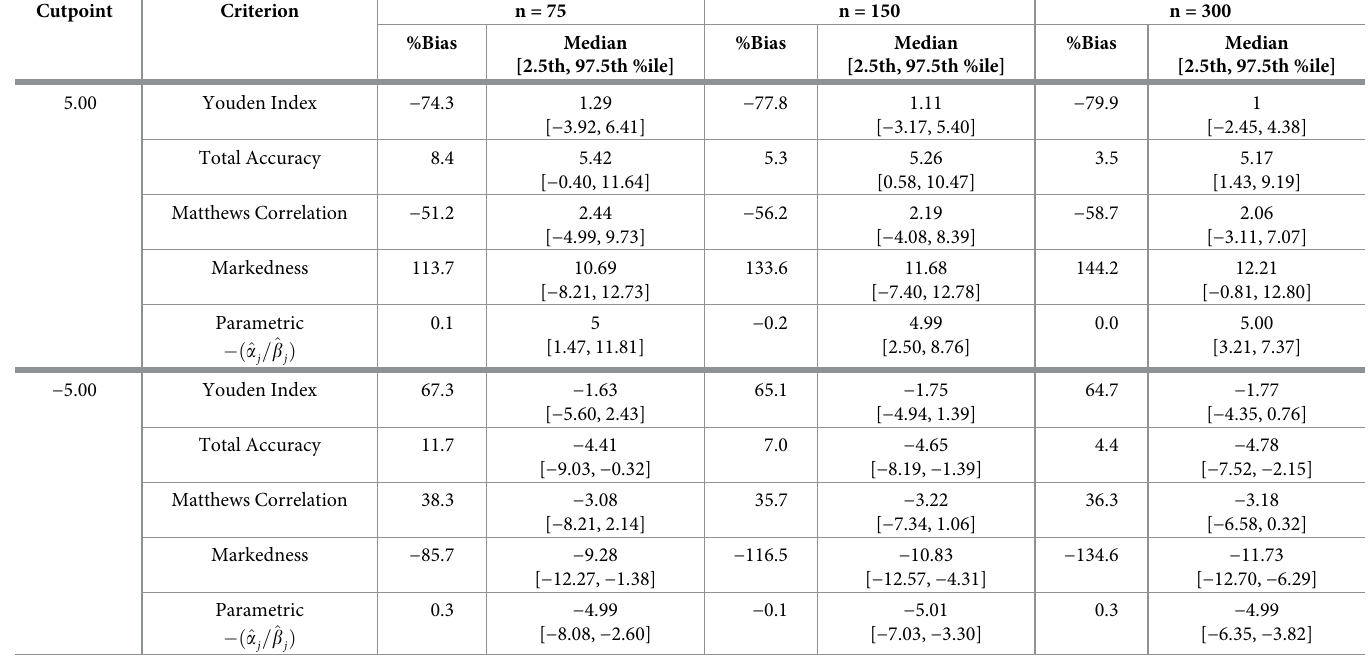
Table 6. Non-proportional odds simulation: NPO1. Percentiles and biases of cutpoints selected from cumulative ROC curves with several criteria and computed para- metrically: 10,000 simulated datasets parameterized for non-proportional odds, AUC 1 = 0.75, and AUC 2 = 0.85.